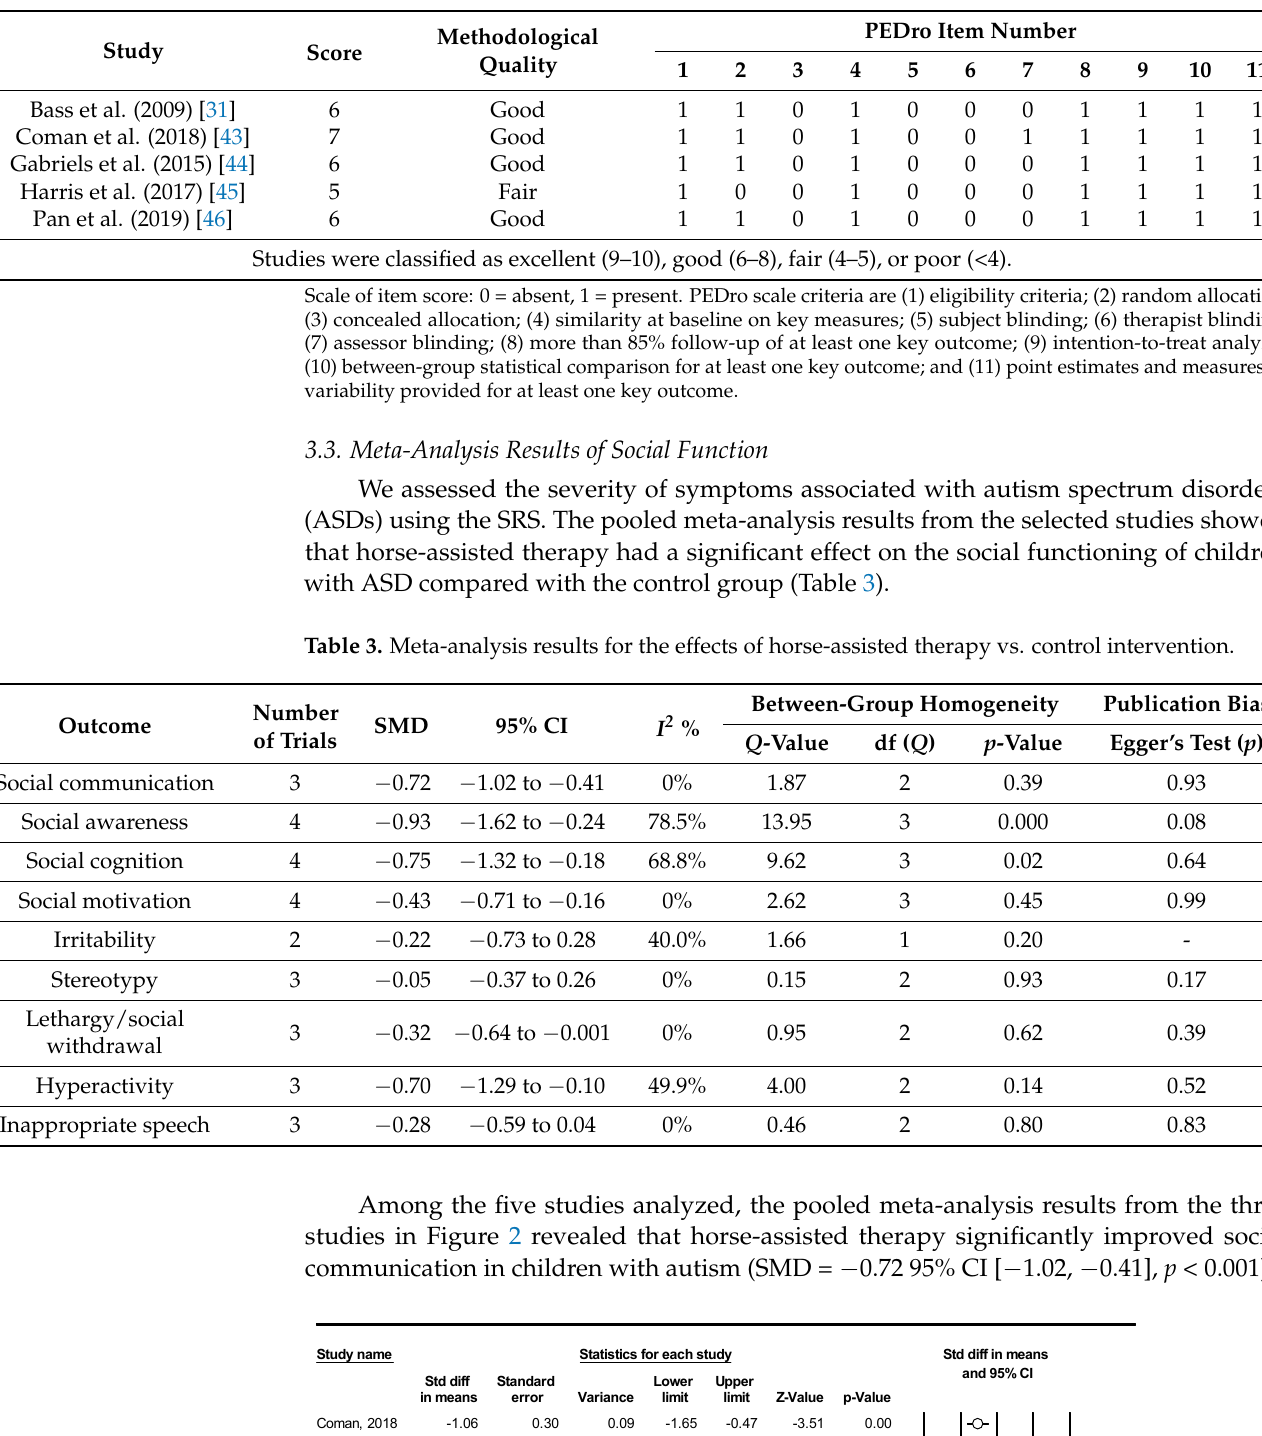
Table 2. Methodological quality of the included studies [31,43–46].